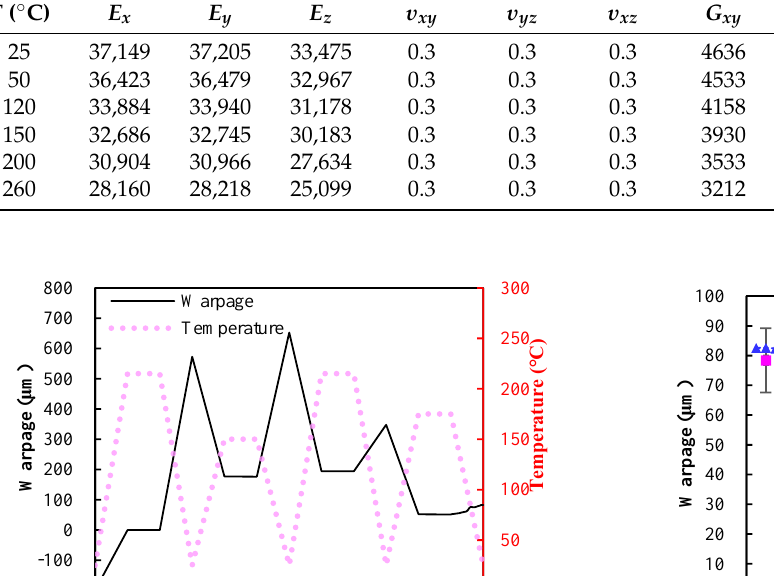
Table 6. Temperature-dependent effective orthotropic elastic properties of core interposer (unit: MPa, ◦ C/ppm). T ( ◦ C)